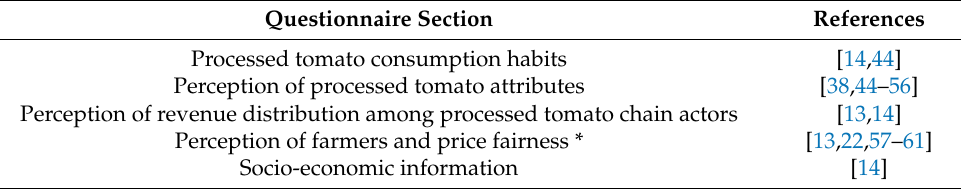
Table 1. Literature sources of the questionnaire.